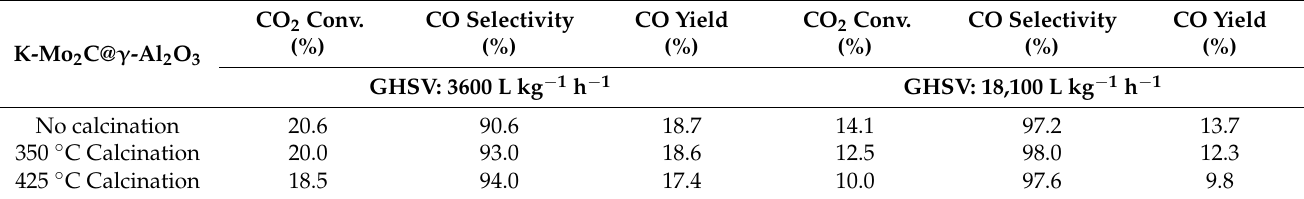
Table 2. RWGS activity for K-Mo 2 C@ γ -Al 2 O 3 prepared using different calcination temperatures.